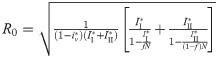
Modelling of the relative contributions of asymptomatic and clinical cases to R0 in a polymorphic human HAT focus without animal reservoirs.We estimated the contribution of asymptomatic and clinical infections to R0 (the basic reproductive number) under equilibrium prevalence by adapting a previously published trypanosomiasis transmission model [11]. Consistent with empirical data showing no domestic or wildlife reservoir, we removed the nonhuman-animal contribution to R0 and instead allowed for a polymorphic human population in which a fraction (f) of the population develop clinical infections when infected (population I), with the remainder (1–f) developing asymptomatic infections (population II). This leads to R0=1(1−iv*)(II*+III*)[II*1−II*fN+III*1−III*(1−f)N], where i*v is the infected tsetse prevalence, II* is the number of clinical infections present at equilibrium, III* is the number of asymptomatic infections at equilibrium, and N is the total human population size. We simulated this equation with epidemiologic and demographic surveys from the Forécariah focus in Guinea. Specifically, there were 13 clinical infections and 16 suspected asymptomatic infections identified during the survey. Of the suspected asymptomatic individuals, one-third tested negative on follow-up using the TL test and one-third developed symptoms [10]. Therefore, we set the number of asymptomatic infections as III* = 16X (where X~Uniform(1/3,1)) and the number of clinical infections as II* = 29–III*. The total population size was set as N = 10,837, based on 7,586 surveyed individuals and a survey completeness of 70%. These results suggest that transmission is not sustainable (R0 < 1) when nearly all infections are either clinical (f > 0.98) or asymptomatic infections (f < 0.02). The shaded areas represent 95% predictive intervals when the number of asymptomatic and clinical infections were sampled 1,000 times. HAT, human African trypanosomiasis; TL, trypanolysis.